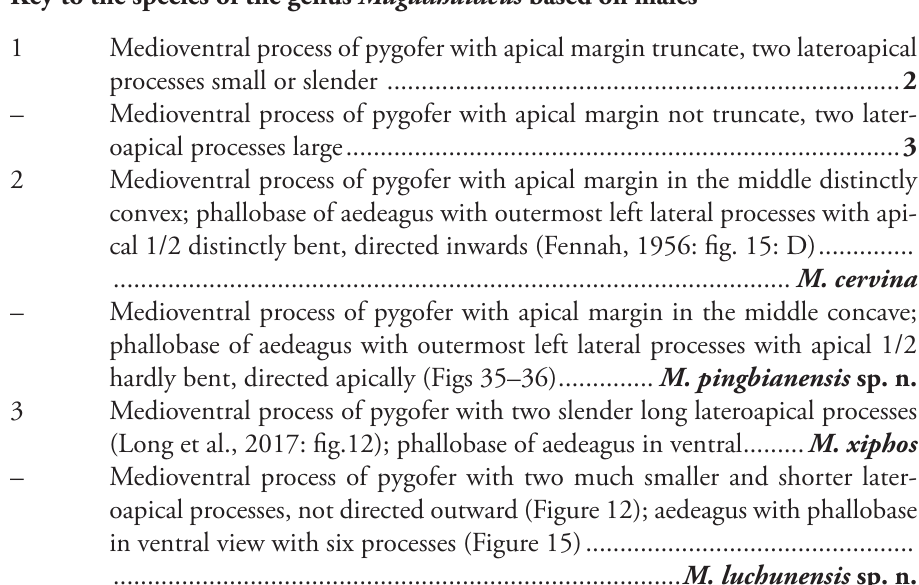
Type material. Holotype: ♂ , CHINA, Yunnan : Lüchun County, Huanglianshan, sweeping, 14 Aug 2014, Zheng-Xiang Zhou. Paratypes: Yunnan : 2 ♂♂ 5 ♀♀ , same data as holotype; 1 ♂ 2 ♀♀ , Lüchun County, Lüboshuiku, sweeping, 13 Aug 2014, Mei-Na Guo; 1 ♂ 3 ♀♀ , Lüchun County, Lüboshuiku, sweeping, 8 Aug 2017, Yang-Yang Liu. Diagnosis. The salient features of the new species include the following: medio- ventral process of pygofer with two much smaller lateroapical processes (Fig. 12); and phallobase of aedeagus with right basal long lobe single, left apical short lobe directed laterally (Figs 14 –15). Description. Measurements. Body length (from apex of vertex to tip of forewing): male 4.9–5.1 mm (n = 2), female 5.0–5.5 mm (n = 7); forewing length: male 4.6–4.8 mm (n = 2), female 4.7–5.2 mm (n =